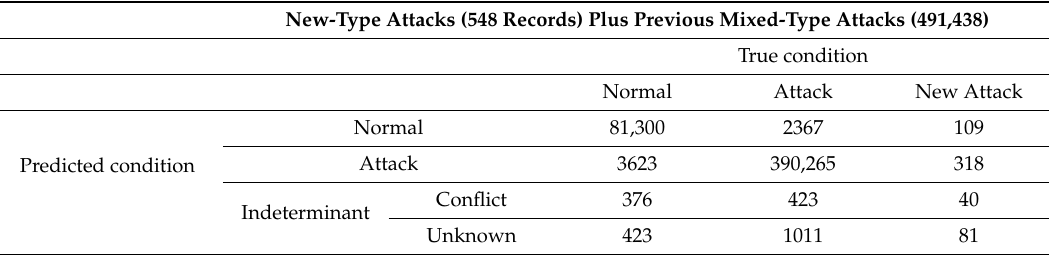
Table 10. Detection performance for new-type attacks, which are completely unseen for the